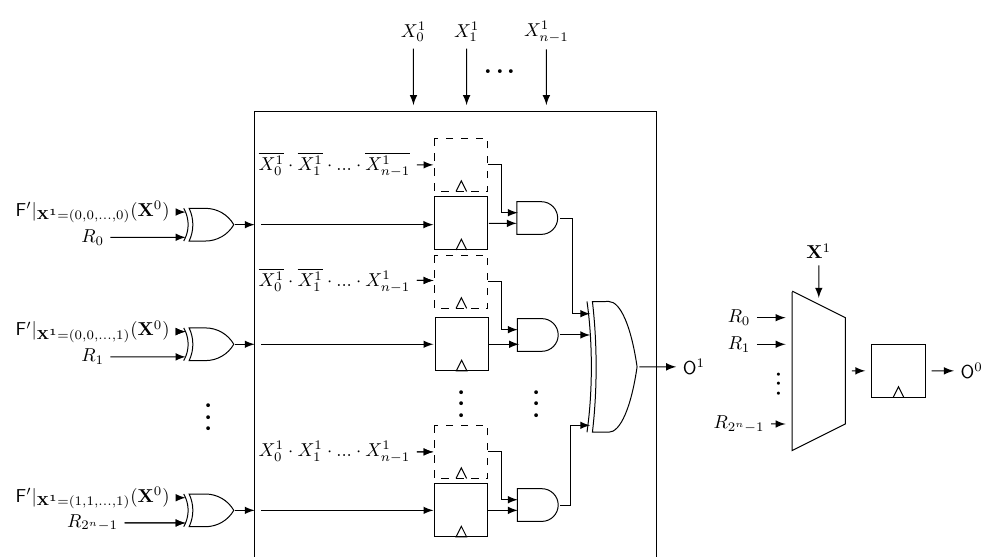
Figure 4: General GHPC LL design with reduced